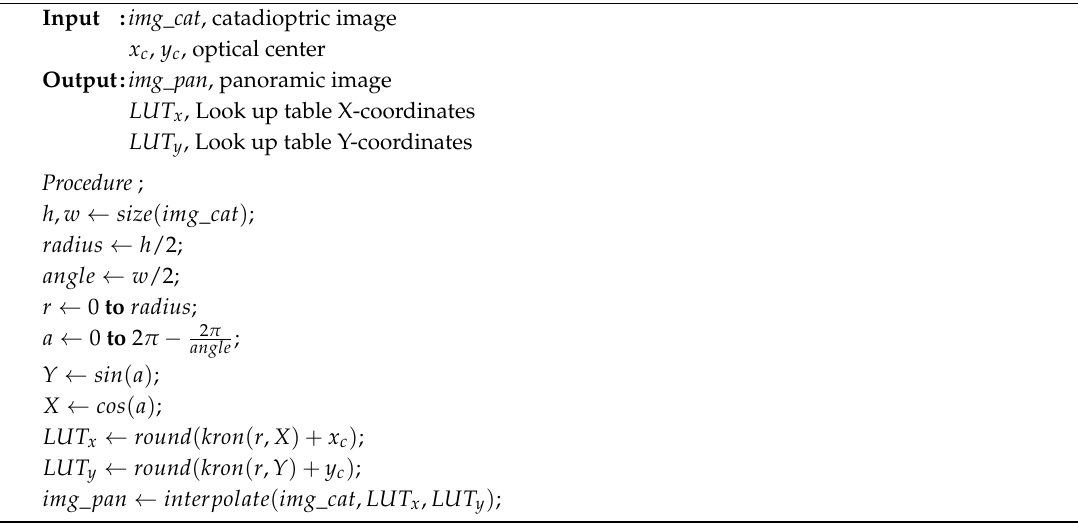
Figure 4. Panoramic 3D reconstruction (best seen in color). The procedure is the following: (1) Capture images from the catadioptric camera system, (2) unwrap the omnidirectional images to obtain panoramic images (3) to search for feature matches and (4) filter the matches using epipolar constraints. (5) Convert features back to catadioptric image coordinates and (6) to mirror coordinates. (7) Perform 3D reconstruction. Algorithm 1: Transforming catadioptric images to panoramic images